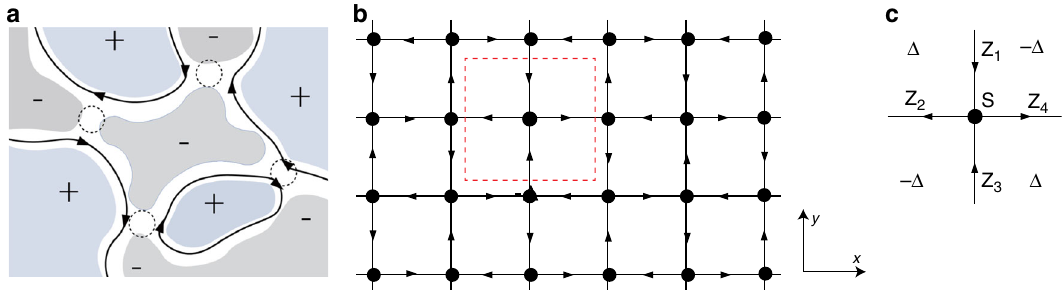
Fig. 4 Chiral edge modes along magnetic domain walls at the transition regime from the QAH insulator to the axion insulator and the Chalker – Coddington network model. a The chiral zero-energy edge states along contours of zero-mass domain walls of Dirac fermions. “ + ” and “ − ” denote domains of positive and negative masses of Dirac fermions, respectively. b The Chalker – Coddington network model on a square lattice. c At each node (red dashed square in b ), a scattering matrix S describes the scattering from incoming (labeled by Z i = 1,3 ) to outgoing modes (labeled by Z i = 2,4 ). The chiral edge modes can be created by Dirac Hamiltonian with four domains of opposite Dirac masses labeled by ±